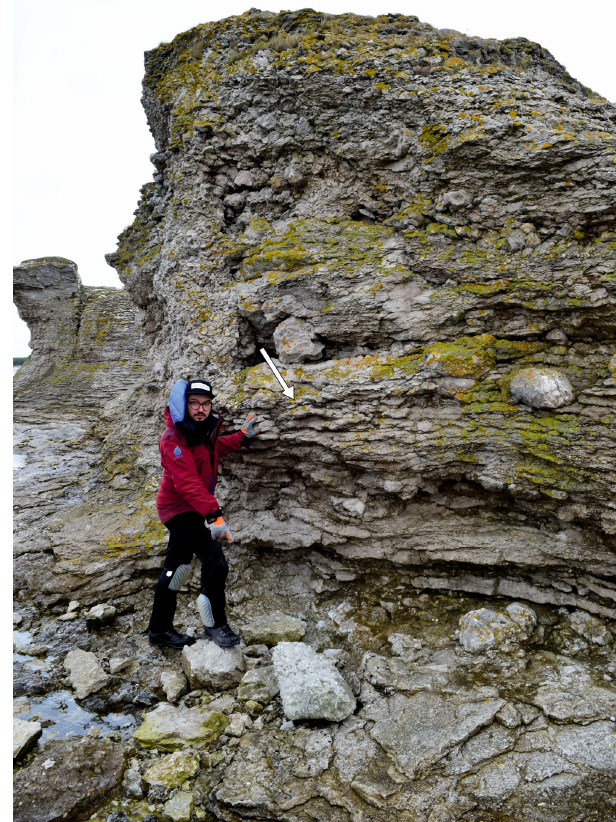
Figure 4. Location of temperature logger on rauk in Gamla Hamn.